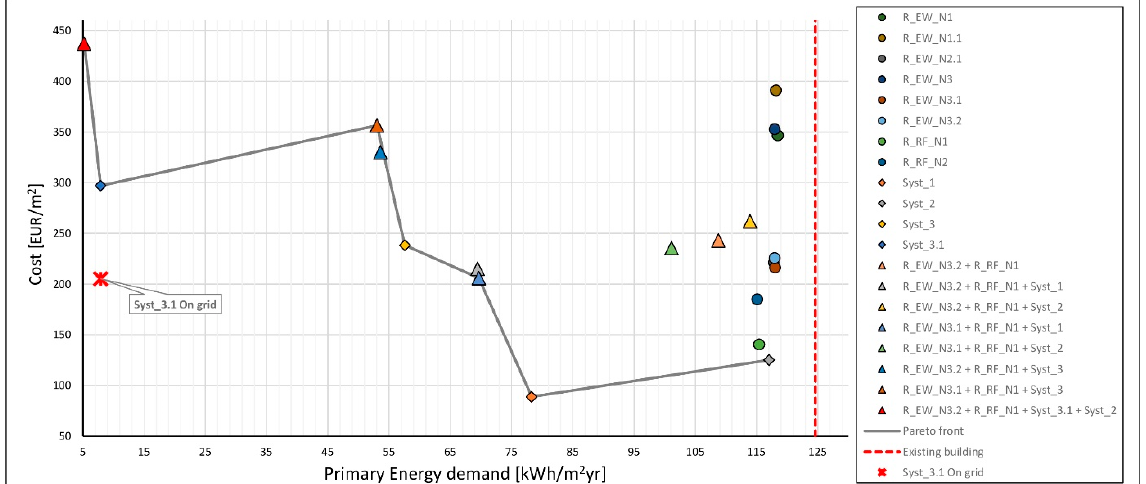
Figure 11. Cost-optimality method results for the macroeconomic scenario for both single redevelopment measures and their combinations and discount factor equal to 4% for Rodari school. The red line in the graph shows the primary energy consumption for the existing building.